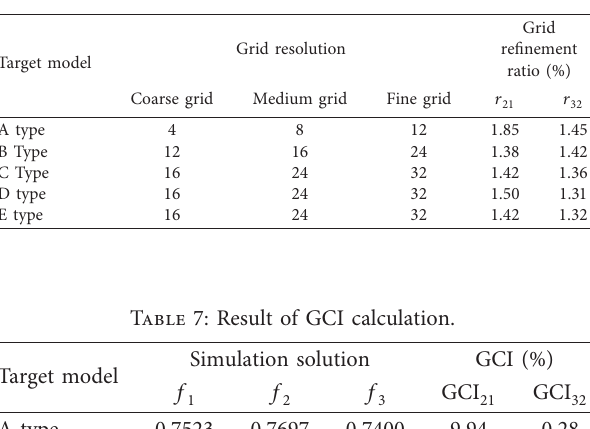
Table 6: Grid refinement ratio of GCI calculation.